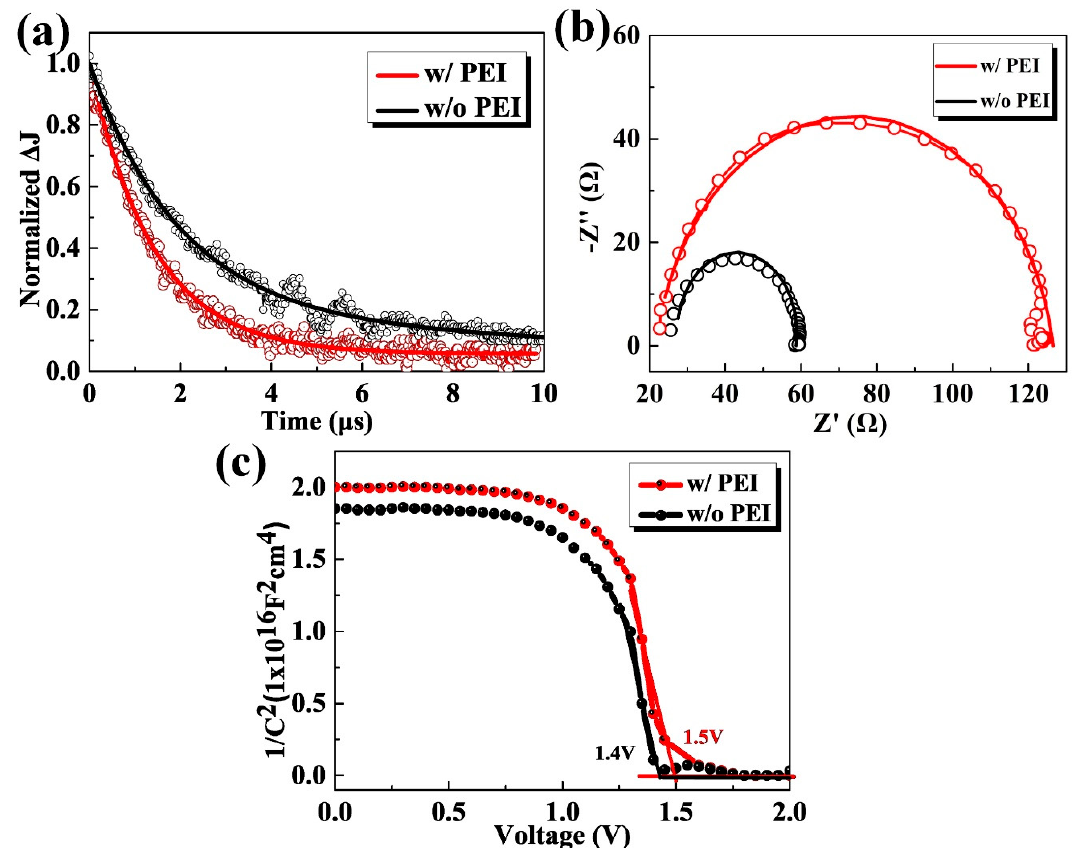
Figure 4. ( a ) Transient photocurrent (TPC) curves, ( b ) Nyquist plots measured with the forward bias voltage of 0.1 V and simulated AM 1.5 G illumination, as well as ( c ) Mott-Schottky results under a dark condition for the CsPbIBr 2 PSCs without and with PEI modification (8 mg/mL), respectively.